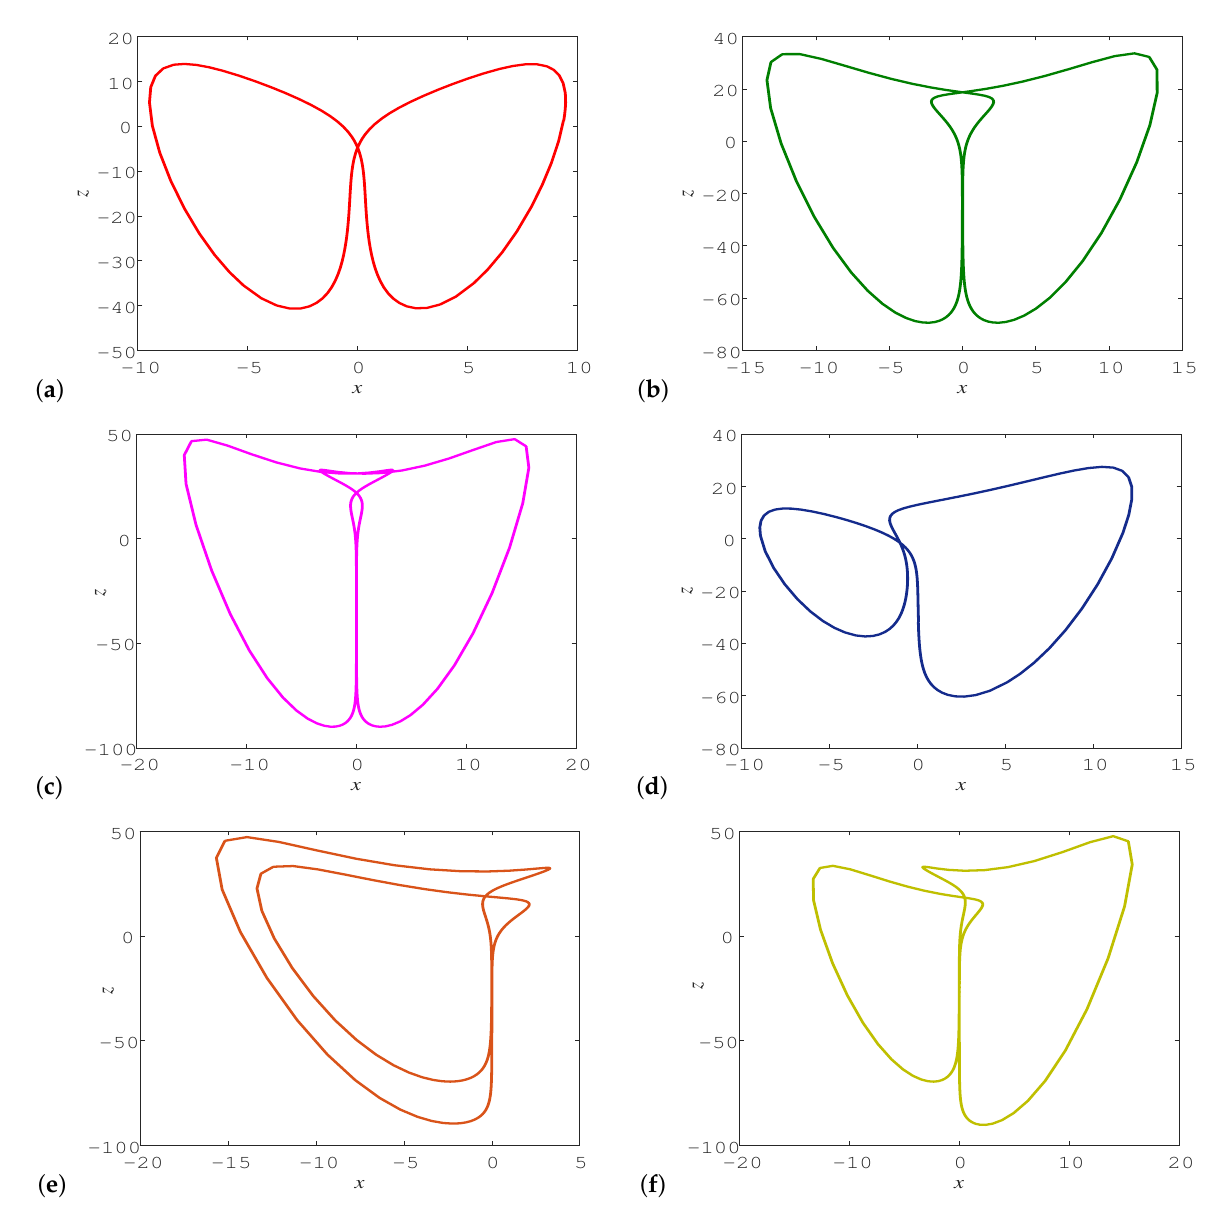
Figure 15. Unstable periodic orbits with topological length of 2 in the new system: ( a ) cycle 01, ( b ) 23, ( c ) 45, ( d ) 03, ( e ) 24, and ( f )